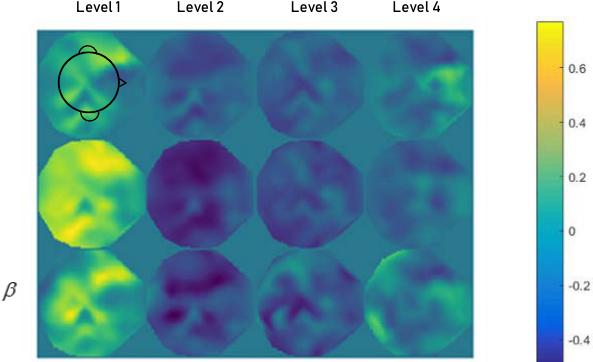
Figure 1. The mean topological spectral maps of θ , α and β at a 4 classes load level. Maps in the first line show the spectral changes in the θ frequency band under different load level. Maps in the second line show the spectral changes in the α frequency band under different load levels. Maps in the third line show the spectral changes in the β frequency band under different load levels. All values have been subtracted from the average spectral value of the whole dataset.